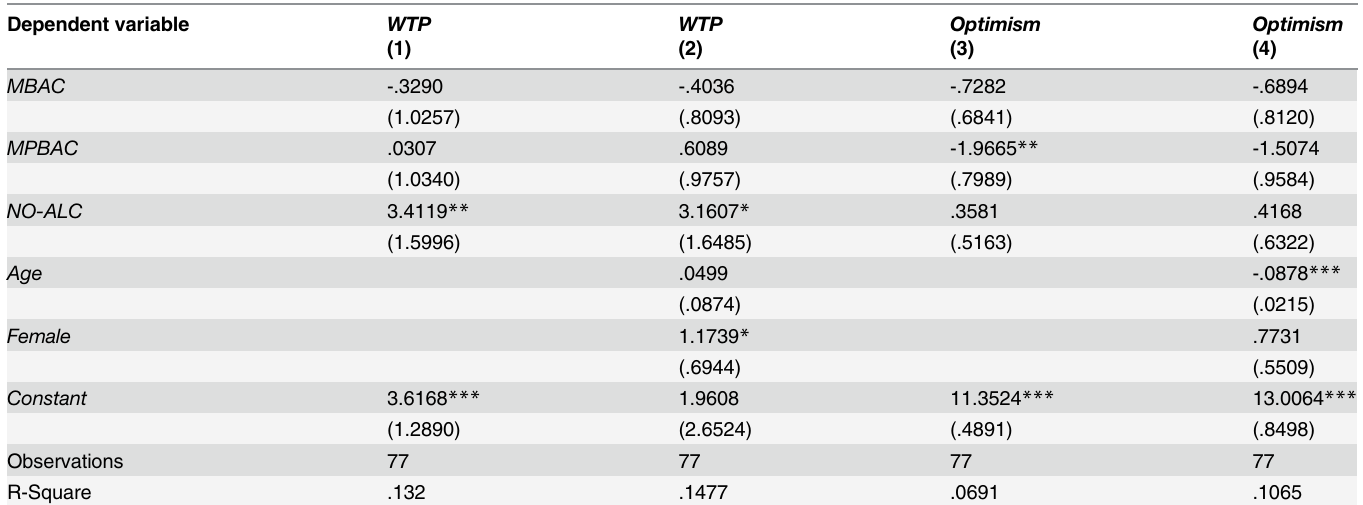
Table 3. Alcohol, Value of Money and